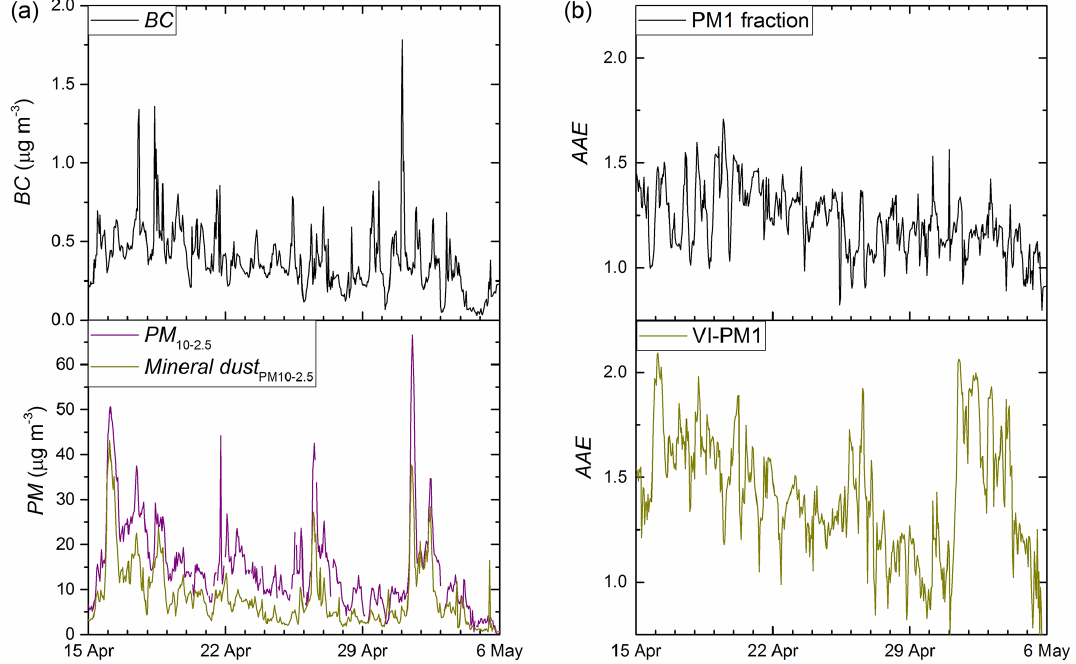
Figure 8. Time series of BC in the fine fraction and mineral dust determined using the VI-PM1 method (a) and Ångström exponent for fine and coarse fraction of the aerosol (b)